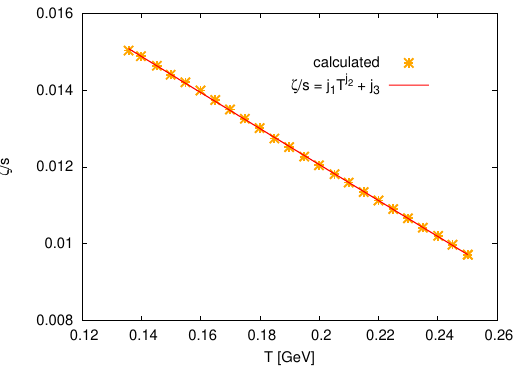
Figure 6. ζ / s is given as a function of T . The symbols are calculations from Equation (18), while the solid curve represents Equation (19).